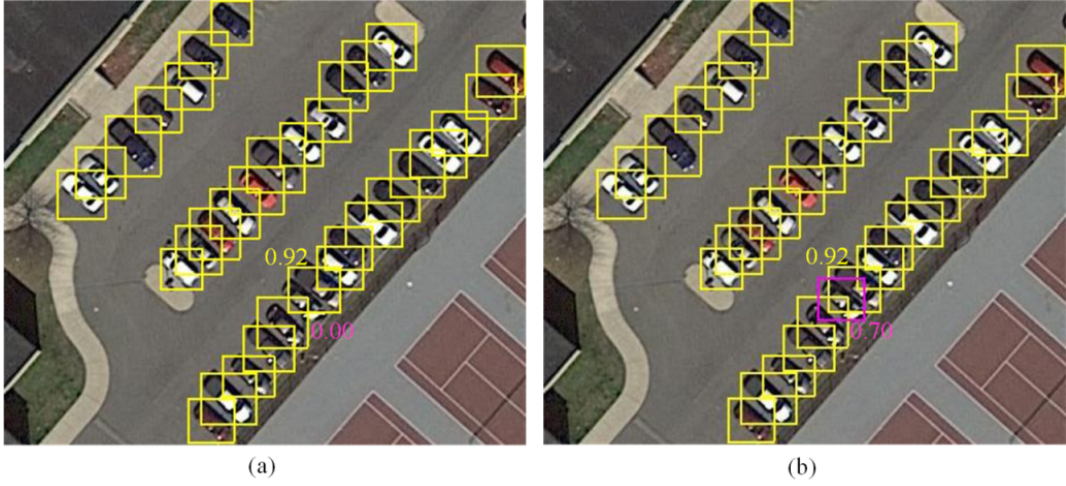
Figure 8. Effect of the Soft-non-maximum suppression (NMS). In ( a ), a car cannot be detected because its confidence is set to 0 by NMS due to its Intersection-over-Union (IOU) with the nearest car, having a higher confidence 0.92, more than a thresh; however, in ( b ), the confidence of the car not detected in ( a ) is set to 0.70 instead of 0 according to Equation